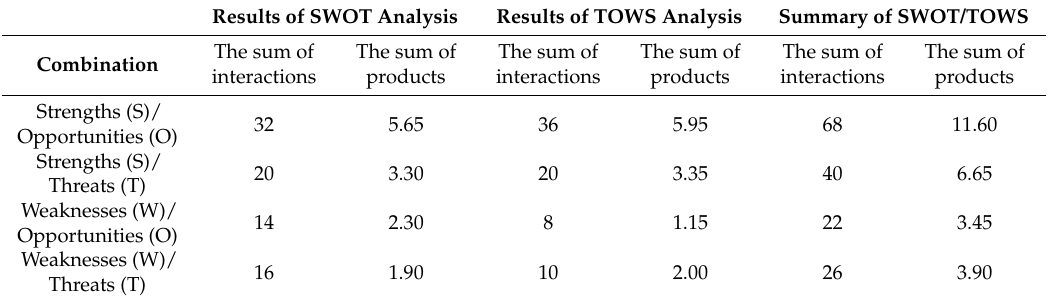
Table 9. Summary of the results of SWOT/TOWS analysis. Source: own